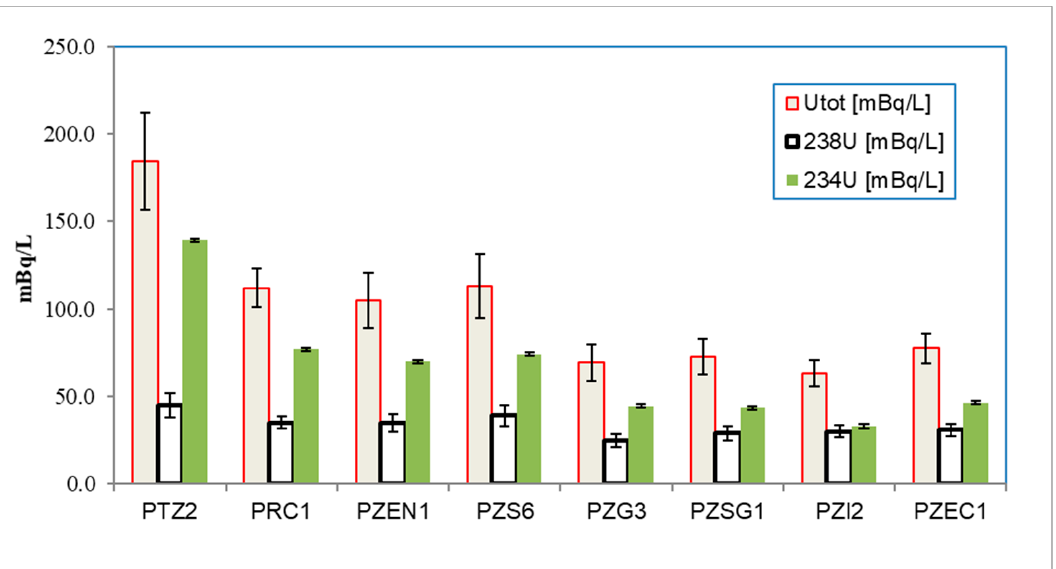
Figure 12. Graph of Total and Isotopic Uranium Concentration in Monitored Piezometers (Median Values) [6].